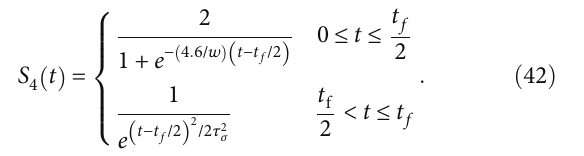
ð t Þ for various dynamic 3